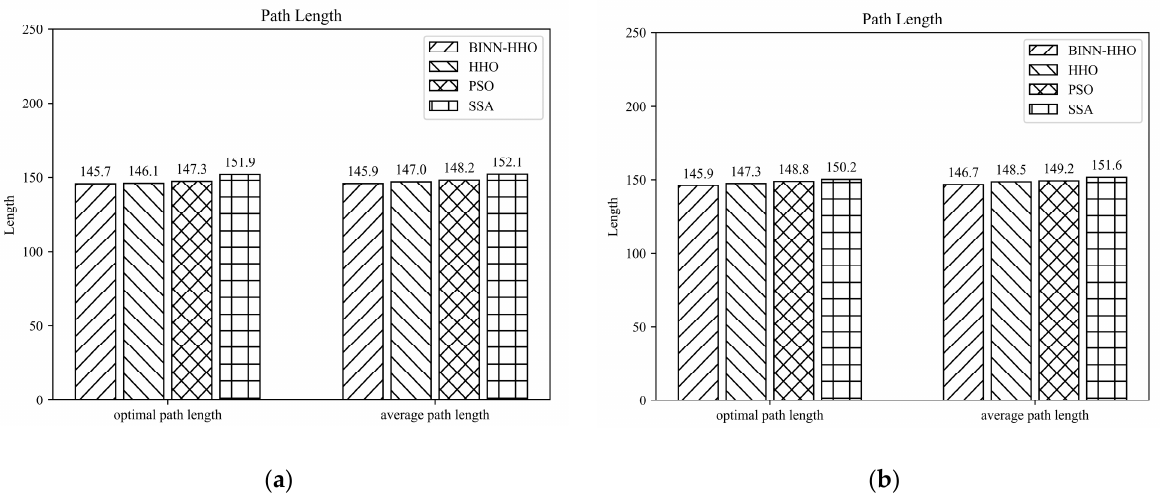
Figure 14. Single-UAV path planning results of BINN-HHO in a dynamic environment (unit: km). ( a ) Dynamic case I. ( b ) Dynamic case II.